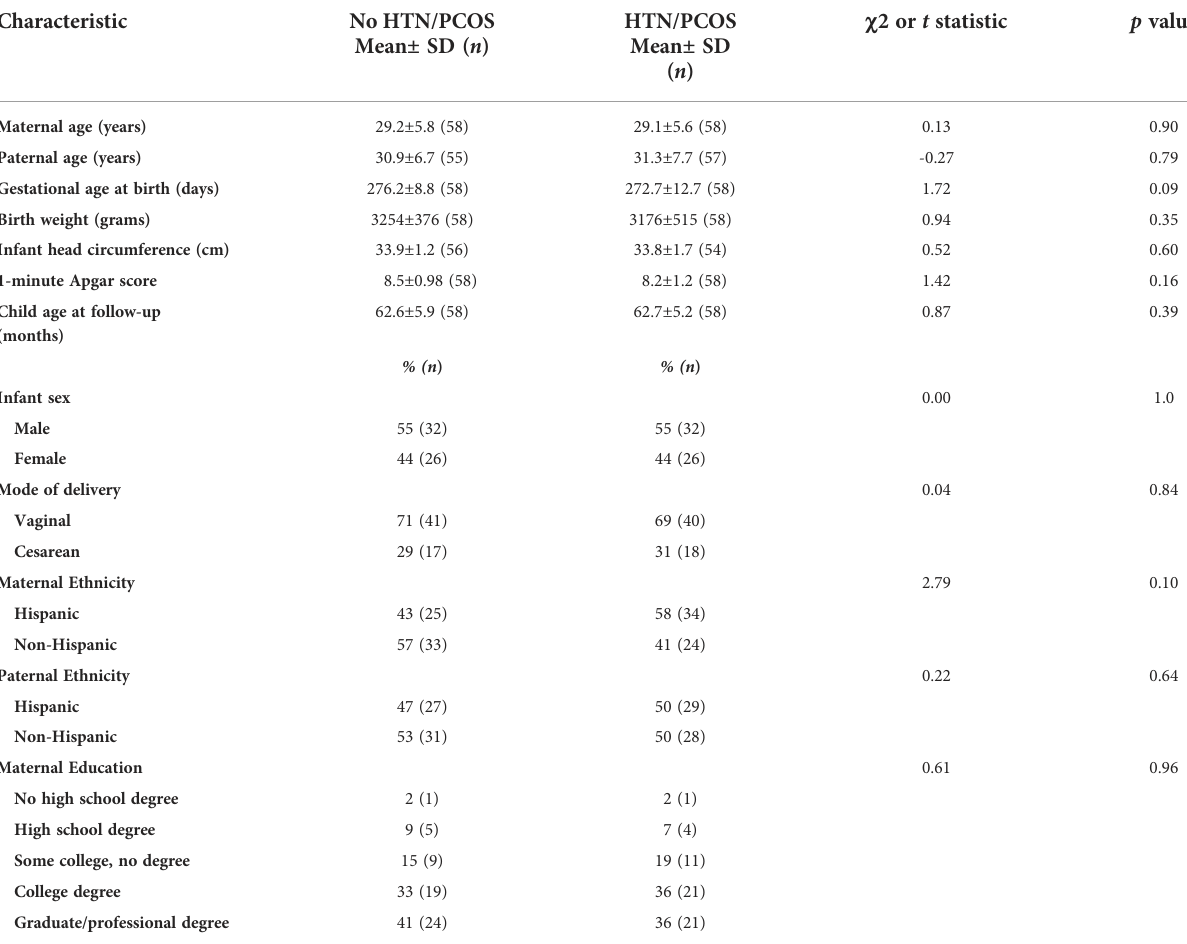
TABLE 1 Study sample